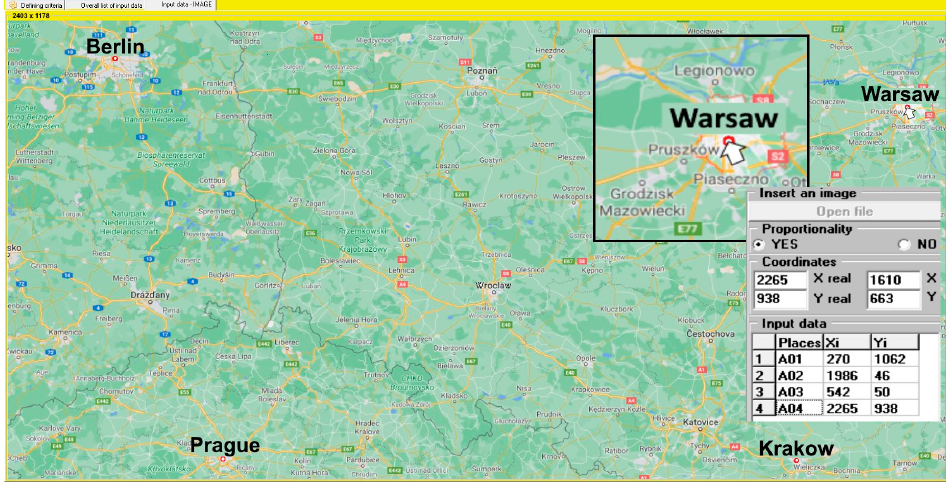
Figure 8. Recording input data about location positions used in the location calculation.